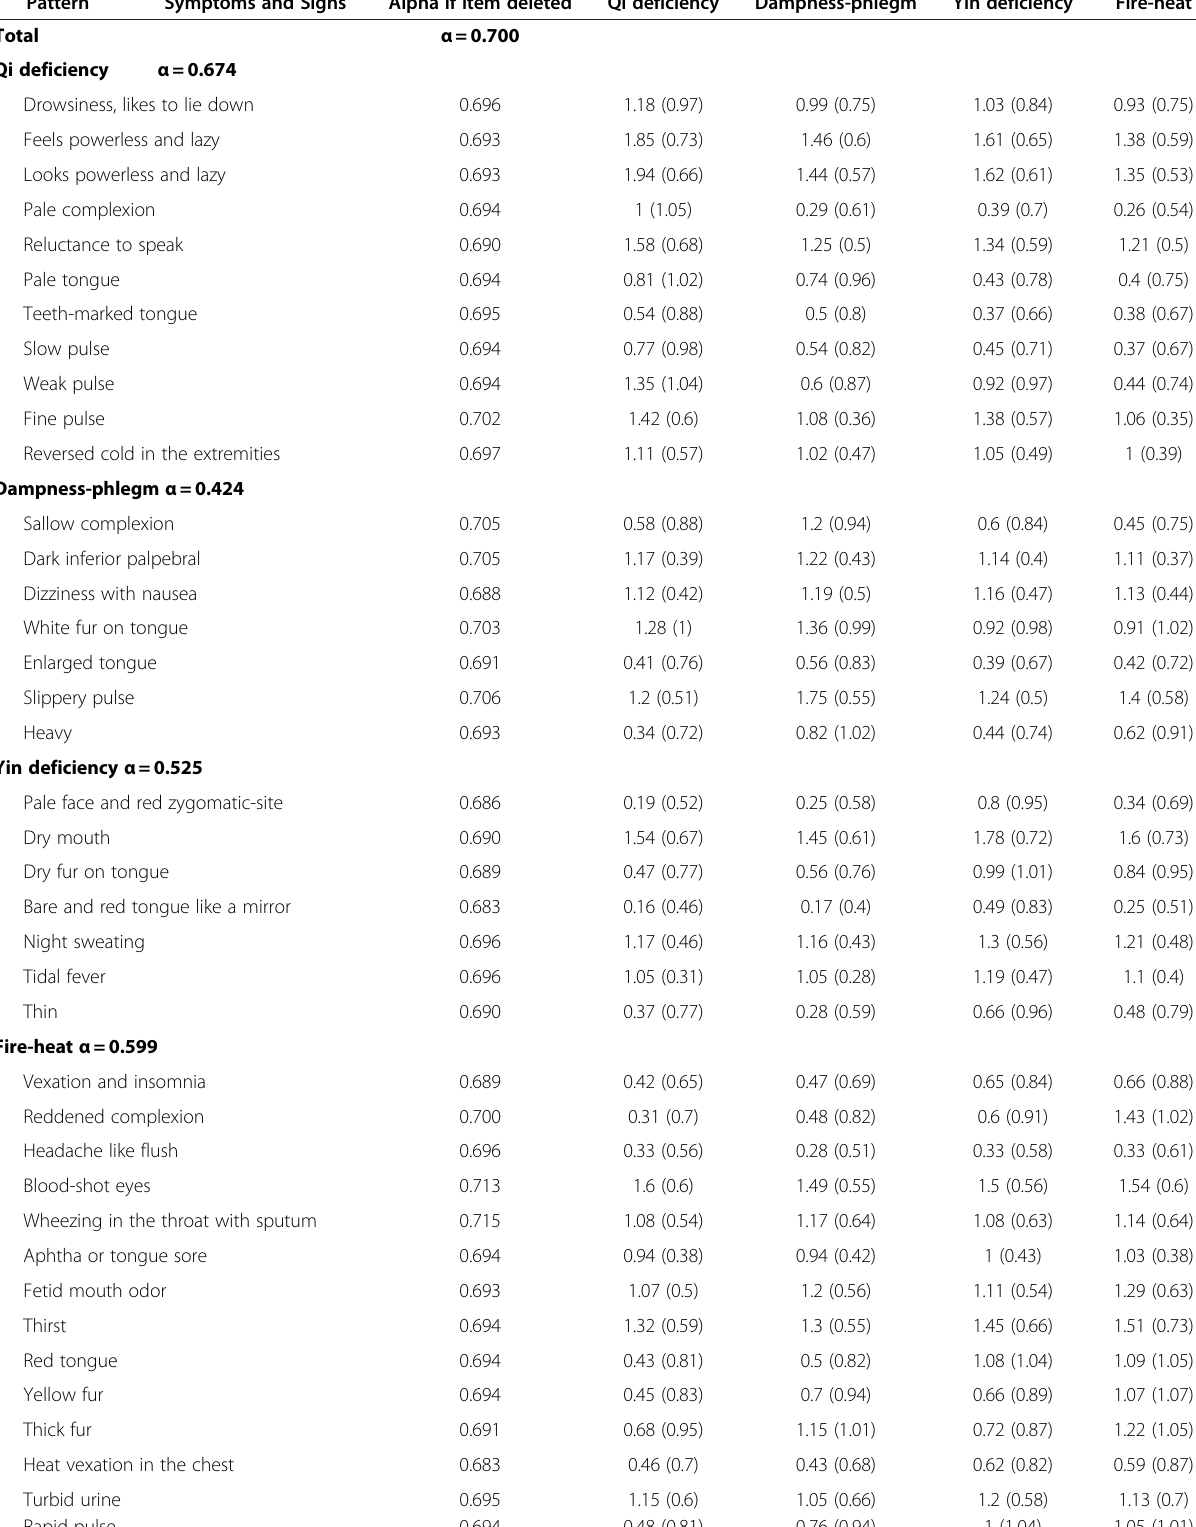
Table 2 Internal consistency (Cronbach ’ s coefficient α ) total and within each pattern and mean scores for each item of